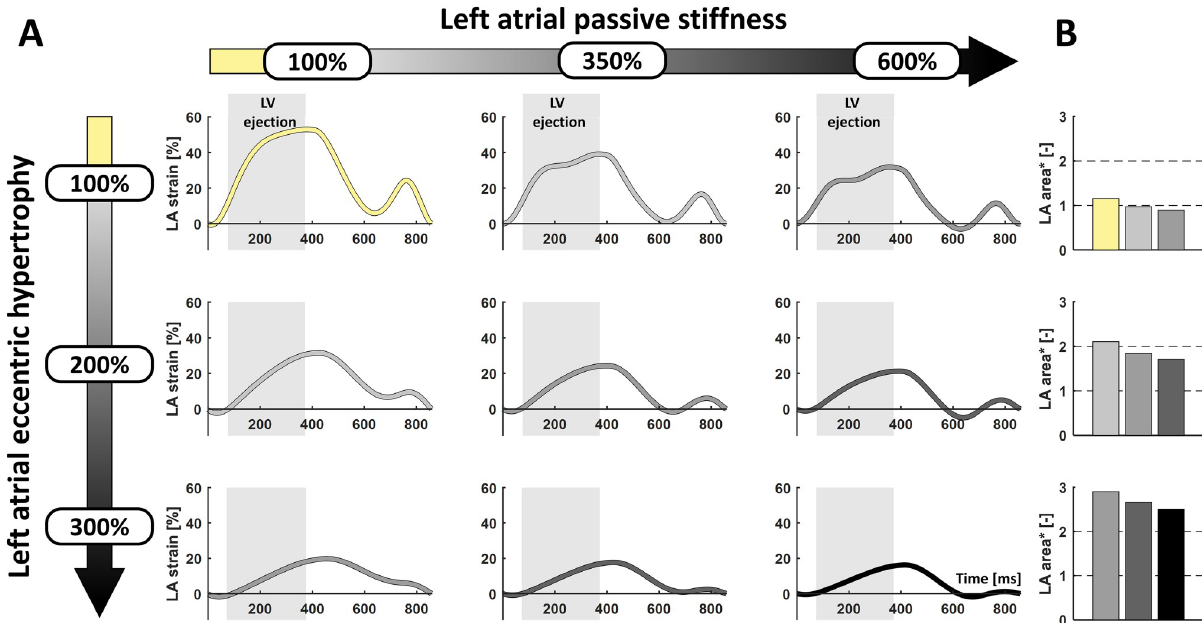
Fig 5. Simulations of LA strain and dilation after acute MR. Simulated changes in (A) LA strain and (B) LA area (i.e. change in LA end-systolic area relative to baseline simulation) of varying severity of LA passive stiffness ( left-to-right ) and LA eccentric hypertrophy ( top-to-bottom ) starting from the simulation of the acute severe MR phase ( yellow ). Vertical gray areas in the strain panels indicate the period of LV ejection.